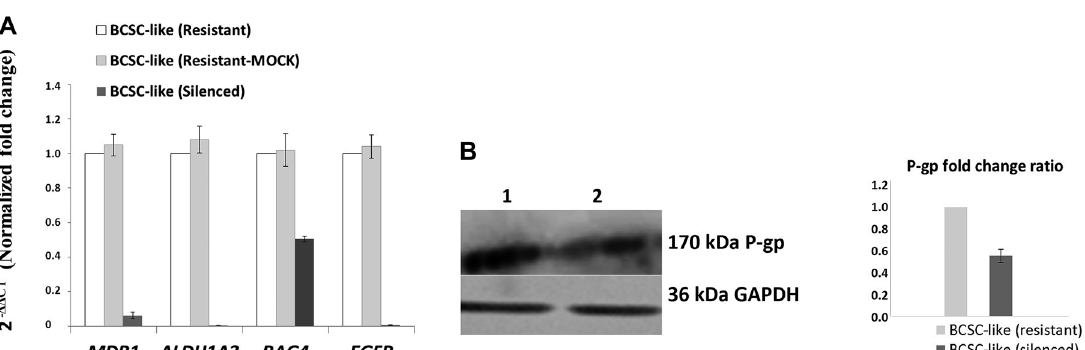
Figure3: Real-timecellproliferationanalysis